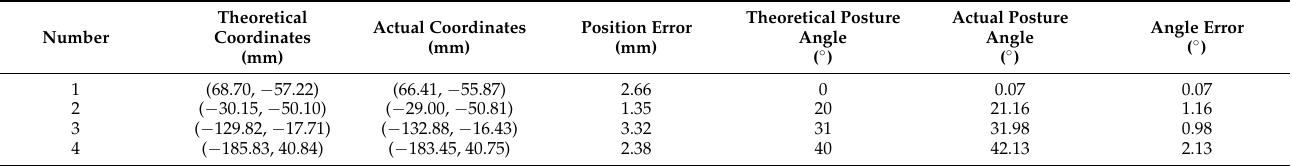
Table 2. Comparison between the theoretical and actual values of the positions and postures at the marker point of the knee joint.